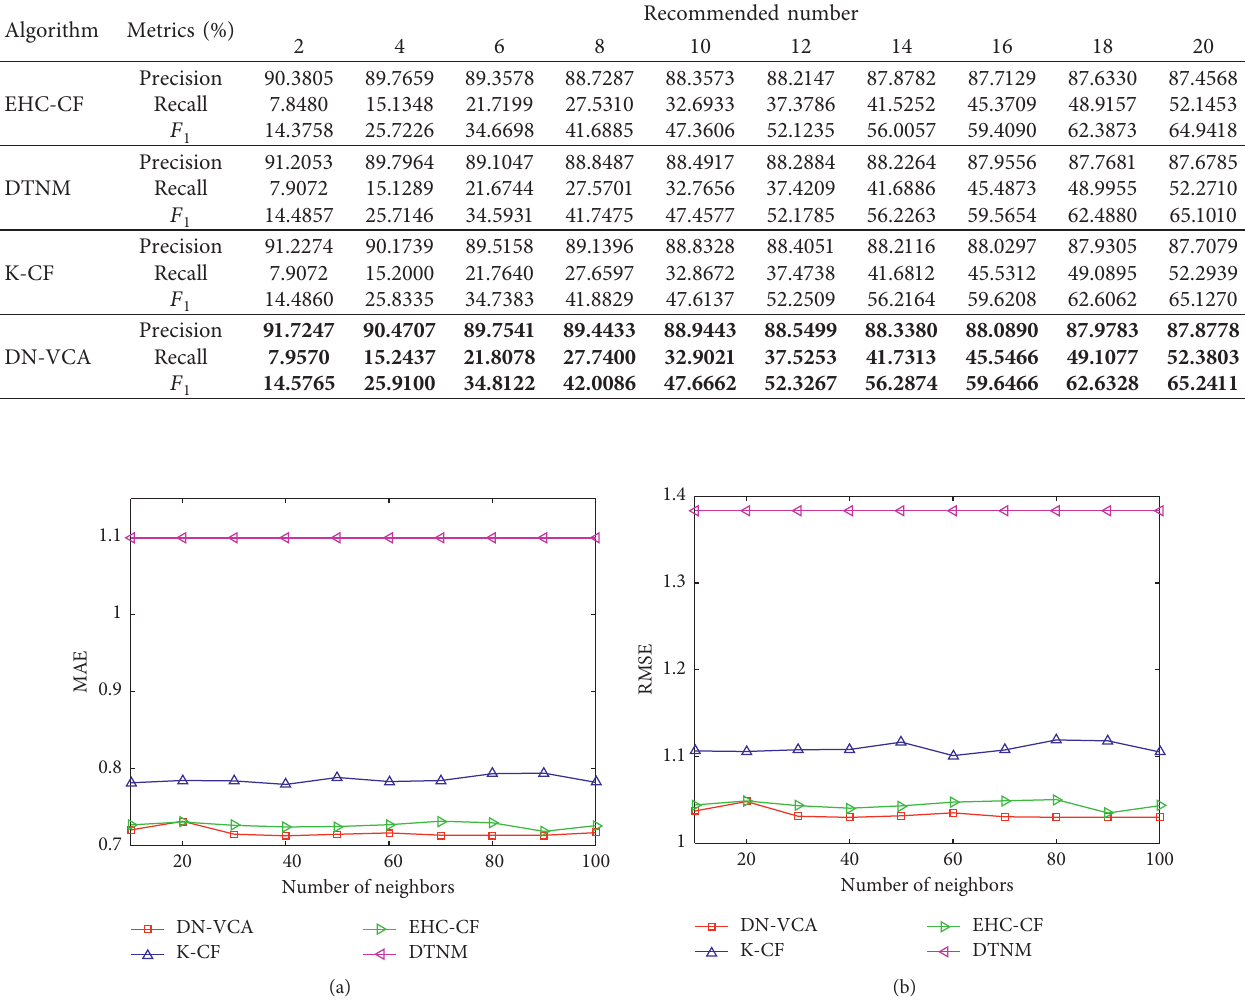
of EHC-CF, DTNM, K-CF, and DN-VCA based on Movielens dataset. 1